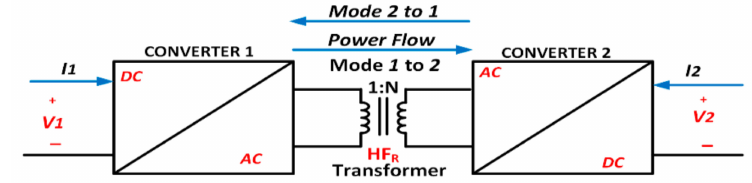
Figure 10. Structure of IBDC (BASIC)